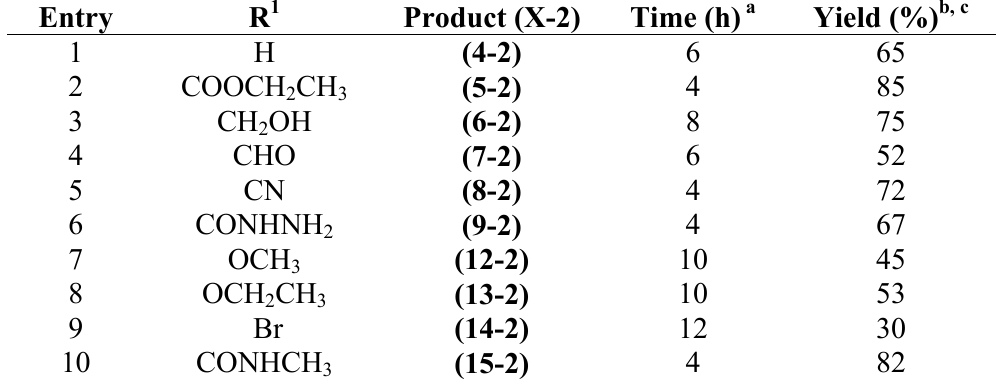
Table 1. Yields and times for the synthesis of 9 H -pyrido[3,4- b ]indol-1(2 H )-one derivative.